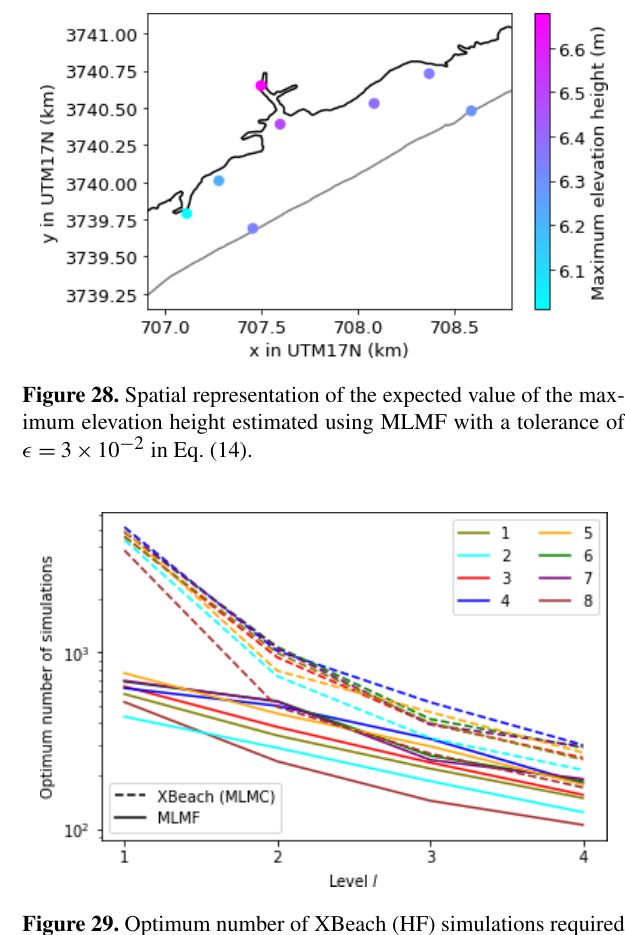
Figure 29. Optimum number of XBeach (HF) simulations required by MLMF (Eq. 14) and MLMC (Eq. B7) for the Myrtle Beach test case. Here (cid:15) = 3 × 10 − 3 in Eqs. (14) and (B7) for MLMF and MLMC respectively.